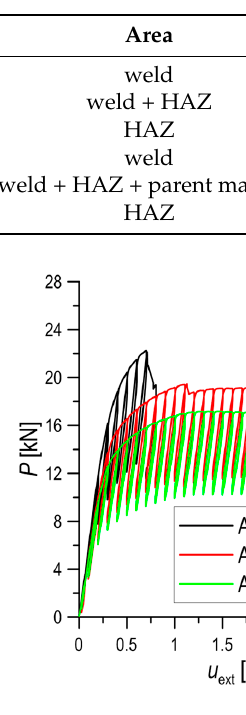
Table 4. Fracture energy of each joint zone.